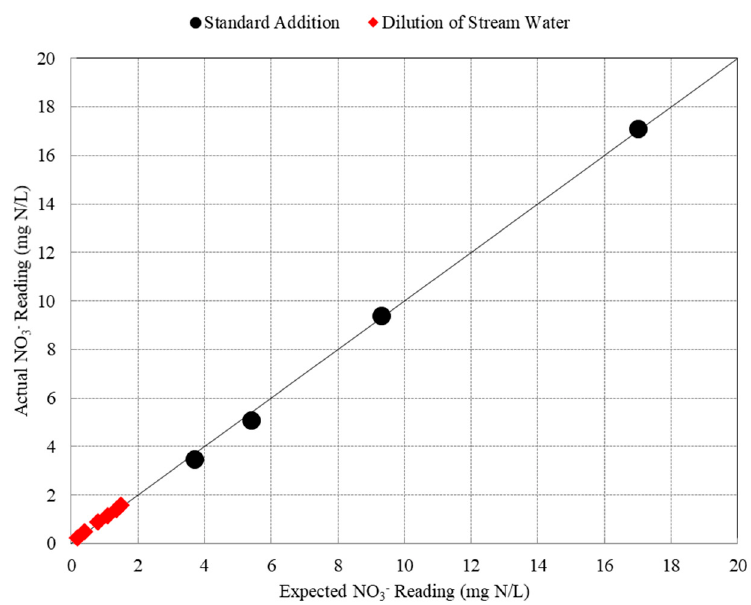
Figure 2. A graph used to verify the stability of the global nitrate calibration used with the in-situ sensor. The red points are from dilution of natural water containing nitrate, and the black points are from standard addition of known nitrate amount to the natural water.